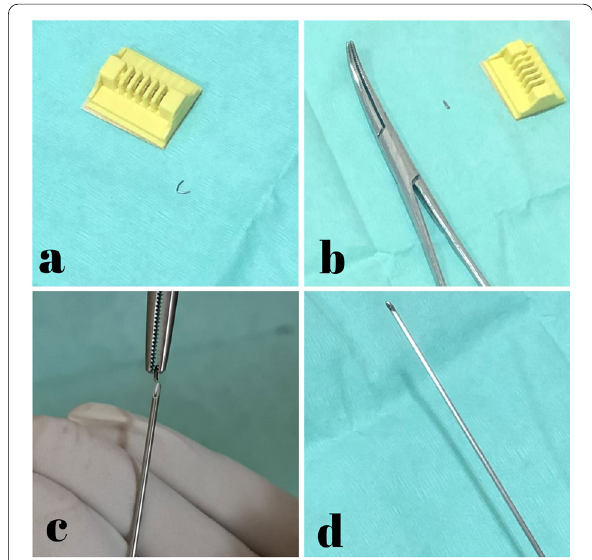
Fig. 1 Technique of surgical clip preparation. a Surgical clip cartilage and the opened clip. b The clip is closed by sterile needle holder and ready for use. c The closed surgical clip inserted within the beveled end of the spinal needle. d The spinal needle with the clip within